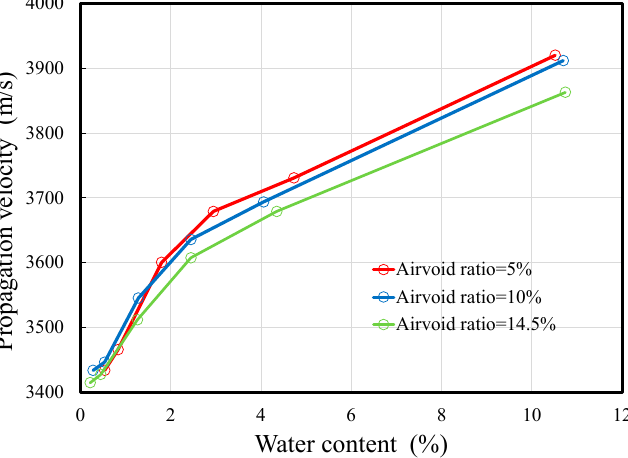
Figure 4. Relationship between the water content and propagation velocity.